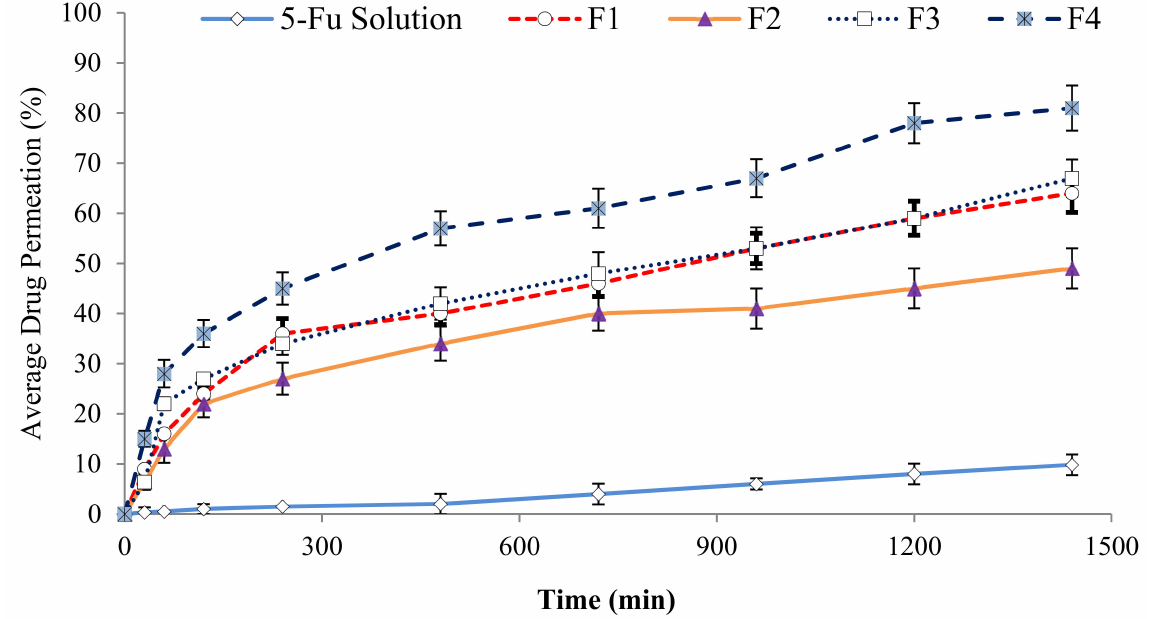
Figure 4. The in-vitro permeation profile of the pure 5-FU solution and the 5-FU emulsion formulations (F1, F2, F3, F4), where F4 exhibited significant difference from rest of formulations, data are expressed as mean ± S.D., n =